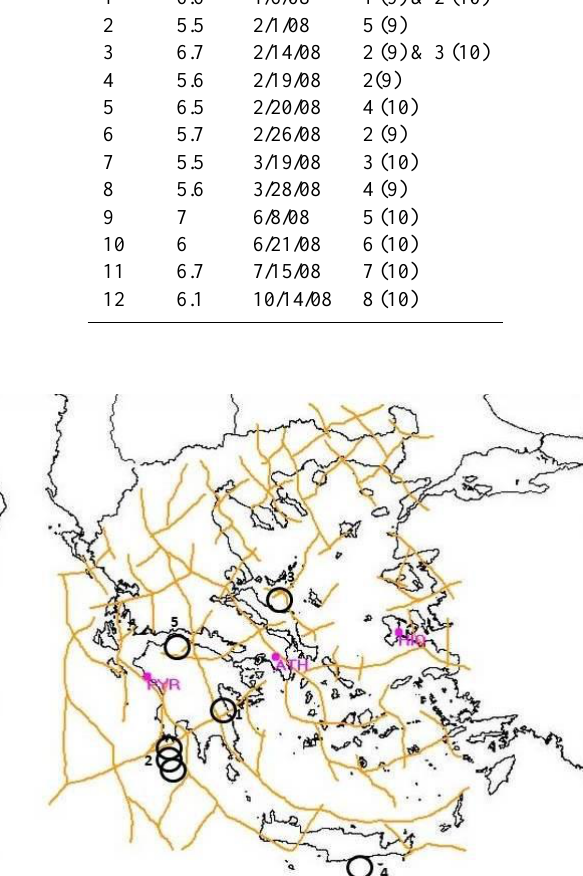
Fig. 7. Classification of EQ-prone area and threshold determination. Fig.7. Classification of EQ-prone area and threshold determination. Fig. 8. EQs that occurred in Greece from January to October 2008 Fig.8. EQs occurred in Greece from January to October, 2008 with magnitudes greater than Ms=6R with magnitudes greater than M s = 6R (Thanassoulas et al., 2009). (Thanassoulas et.al., 2009) 8 segments), 240 (equal to a sampling period of 4 h and di- viding the data into 6 segments), 288 (equal to a sampling period of 4.8 h and dividing the data into 5 segments), 360 (equal to a sampling period of 6 h and dividing the data into 4 segments), 480 (equal to a sampling period of 8 h and di- viding the data into 3 segments), and 720 (equal to a sam- pling period of 12 h and dividing the data into 2